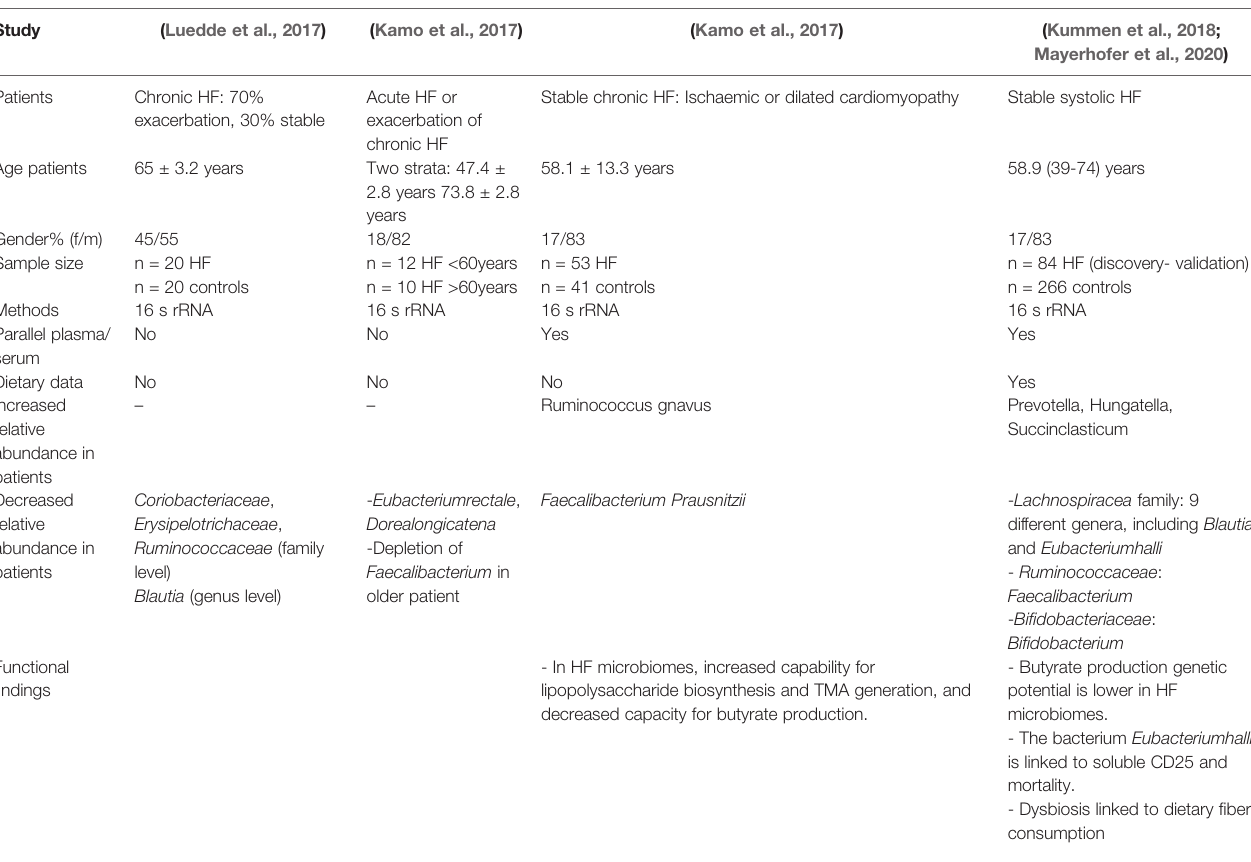
TABLE 3 | Recent gut microbiome sequencing investigations in heart failure patients